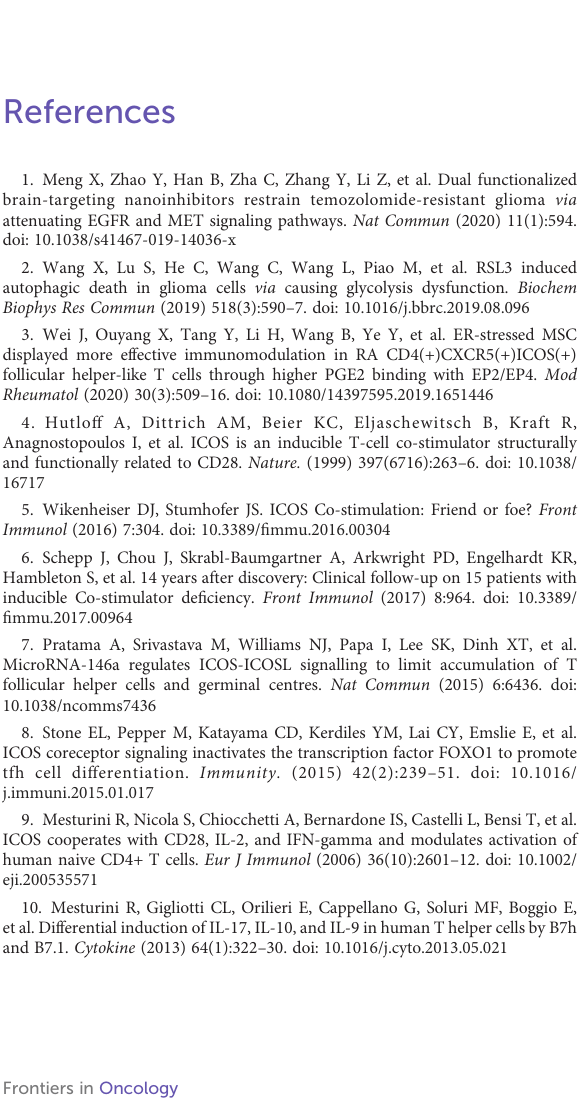
SUPPLEMENTARY FIGURE 8 Relationship between ICOS and immune cell subpopulations in CGGA325 dataset. (A) Correlation between ICOS andimmune cell subpopulations in lower-grade glioma. (B) Correlation between ICOS and immune cell subpopulations in glioblastoma. SUPPLEMENTARY FIGURE 9 Comparison of cell fraction correlation between ICOS and other checkpoints in CGGA301 and TCGA datasets. SUPPLEMENTARY FIGURE 10 Survival analysis and Cox proportional hazards regression analysis according to ICOS expression in CGGA325 dataset. (A – C) Survival analysis in CGGA325 dataset. (D) Univariate and multivariate Cox regression model in CGGA325